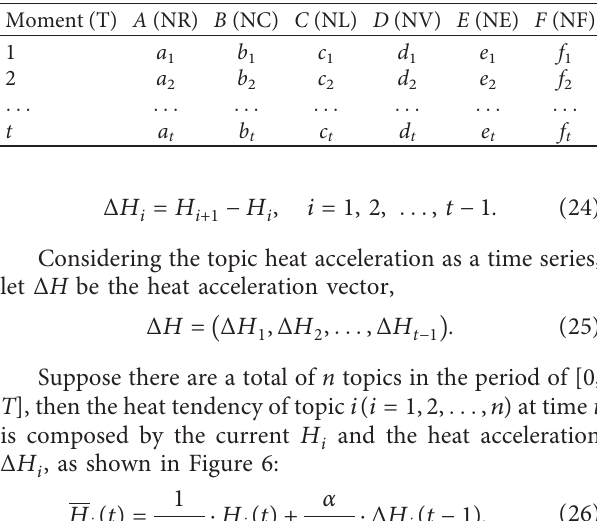
Table 3: Data of topic heat based on users’ behaviour